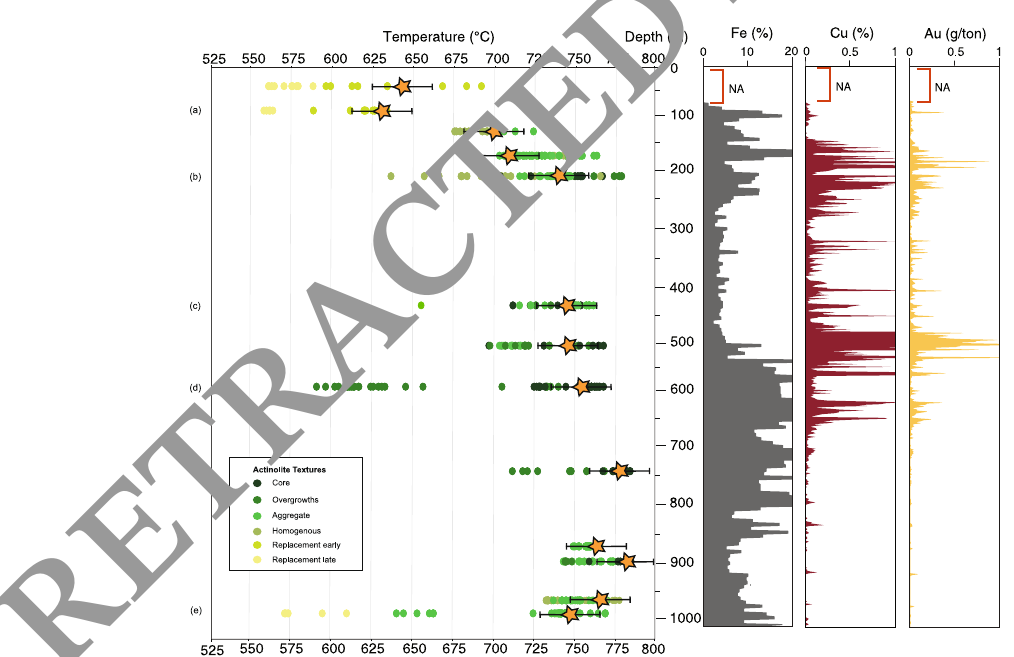
Fig. 2 Calculated temperatures of actinolite crystallization plotted as a function of depth in drill core LD1687. Letters a – e indicate samples with calculated temperature distribution maps (see Fig. 3). Letters correspond to the maps in Fig. 3. The vertical plots display variation of the Fe, Cu, and Au grades with depth at Candelaria (whole rock data obtained from 2 m-long half drill core samples, Lundin Mining, internal report). Orange stars correspond to average temperature values from early actinolite textures (e.g., grain cores), and error bars correspond to maximum temperature uncertainty when a.p.f.u. Ca deviates from 1.8 23